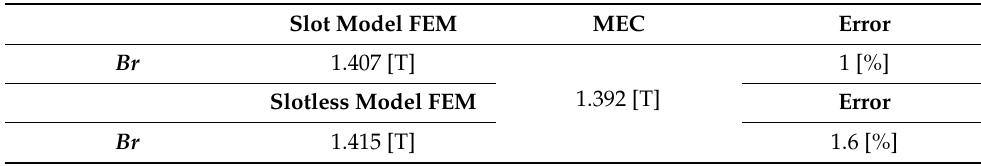
Table 1. Air gap magnetic flux density analysis